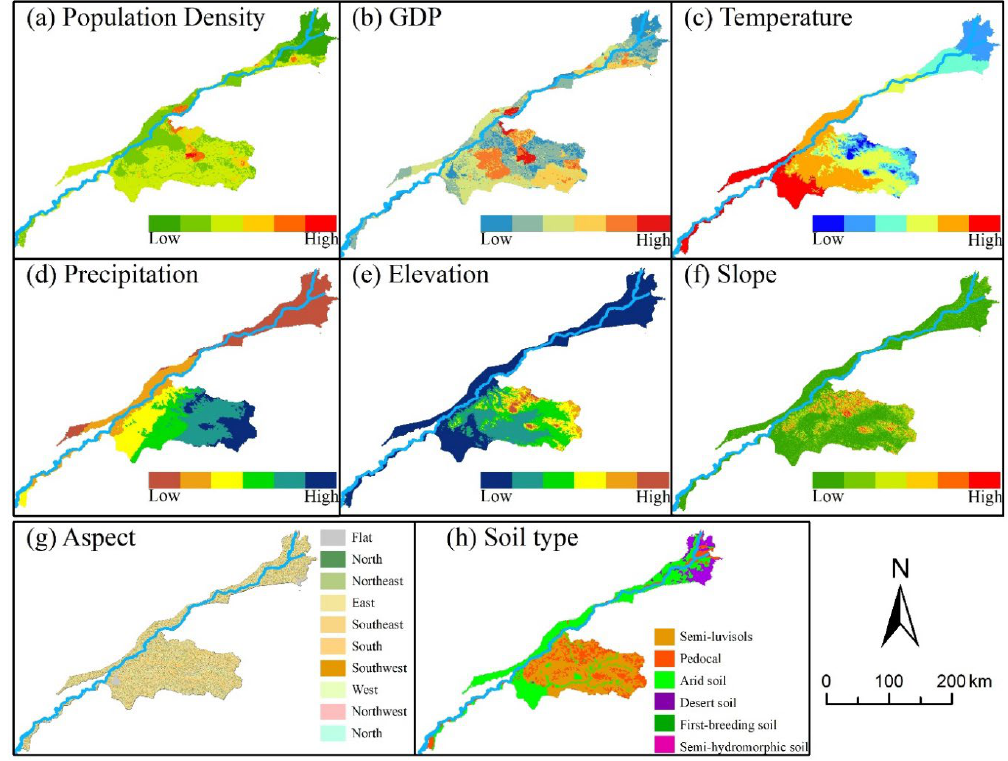
Figure 2. Impact factor spatial distribution map. ( a ) The spatial distribution of population density; ( b ) the spatial distribution of GDP; ( c ) the spatial distribution of mean annual temperature; ( d ) the spatial distribution of precipitation; ( e ) the spatial distribution of elevation; ( f ) the spatial distribution of slope; ( g ) the spatial distribution of aspect; ( h ) the spatial distribution of soil type.